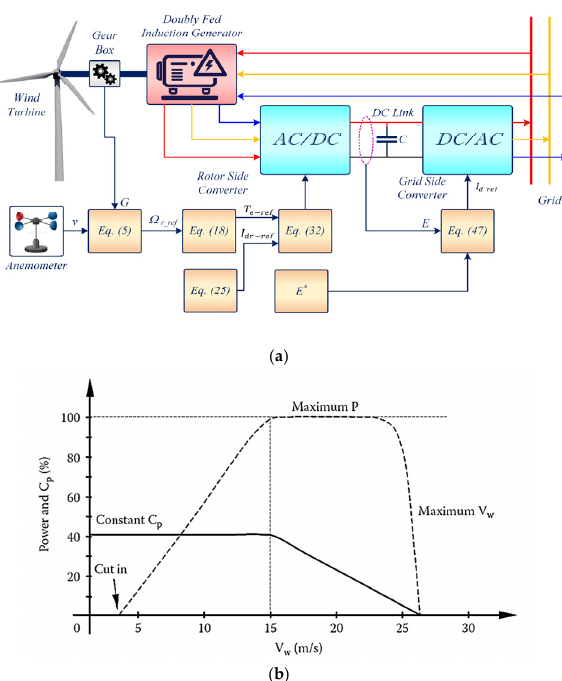
Figure 3. ( a ) Schematic of the doubly fed induction generator (DFIG)-based wind energy conversion system (WECS); ( b ) ideal wind turbine power curve .